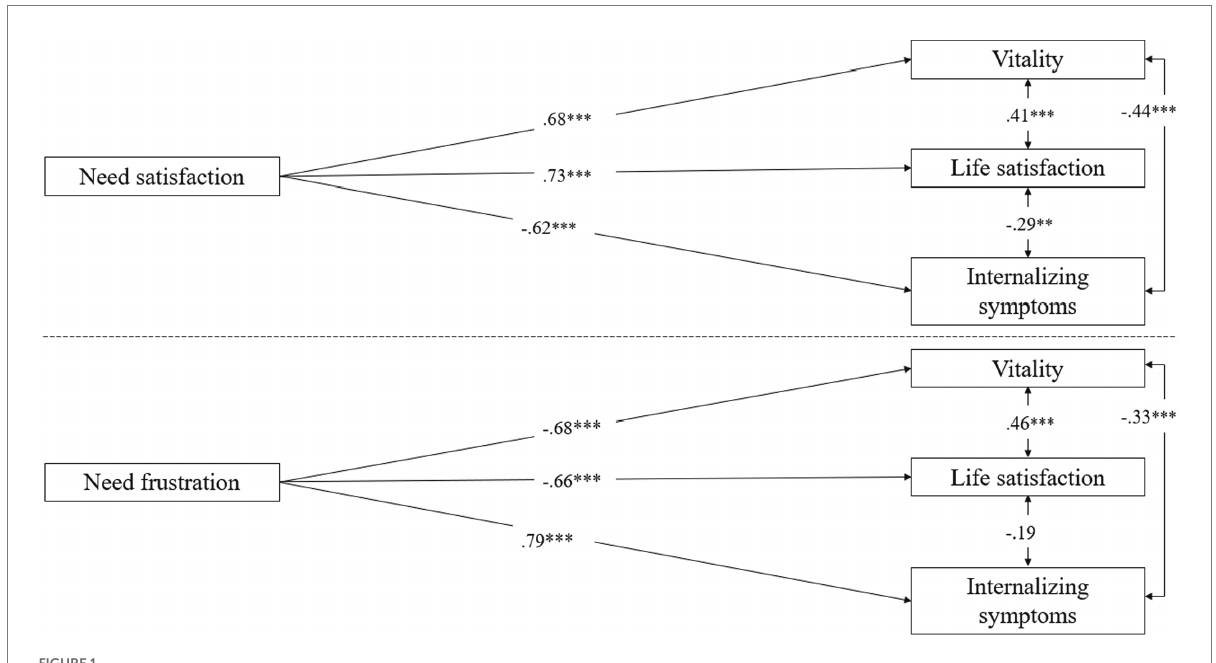
FIGURE 1 Structural model depicting the relation between need-based experiences and indicators of well-being and Ill-being. The measurement model and the effects of the control variables are not shown for reasons of clarity. The dashed line separates the two tested models with need satisfaction or need frustration as predictor of the outcomes. ** p < 0.01; *** p < 0.001.